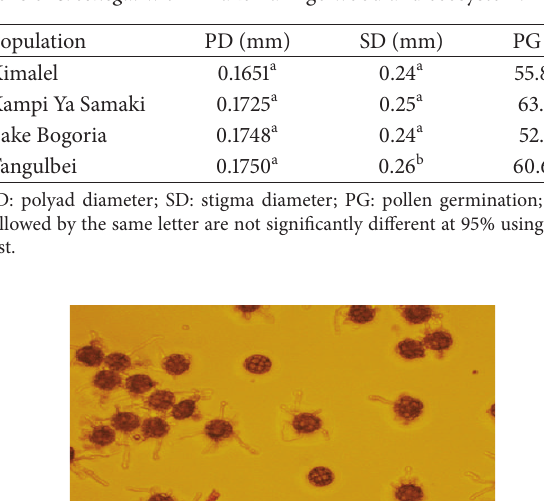
Difference among populations ∗ ∗ ns ∗∗ ns ∗∗ Significant at 𝑃 < 0.01 ; ∗ significant at 𝑃 < 0.05 ; ns: nonsignificant; PL: pod length; PW: pod width; SPP: number of seeds per pod; SW: weight of 1000 seeds; FF: fully formed seeds; data followed by the same letter are not significantly different at 95 % using Fisher’s LSD